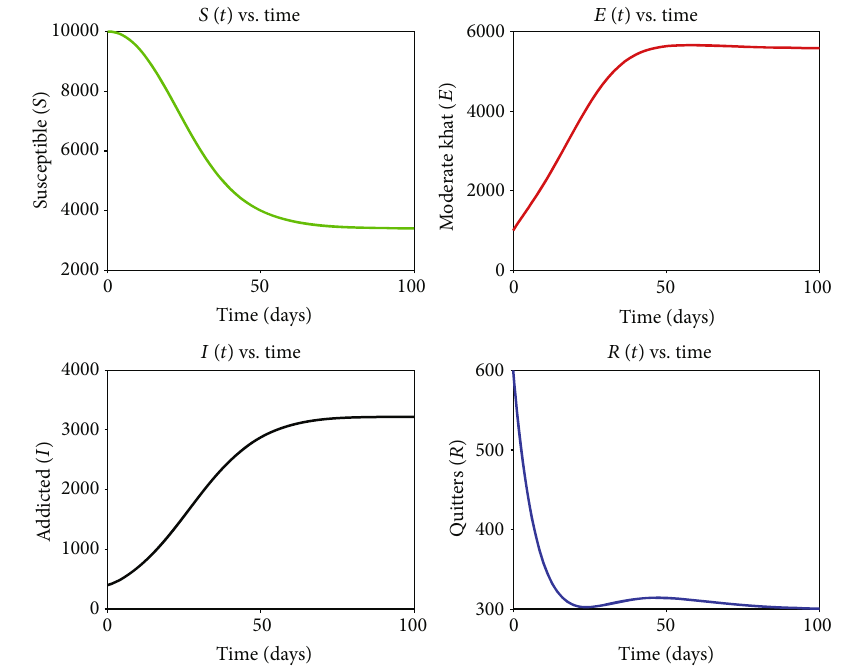
Figure 3: Time series plot of state variables for R